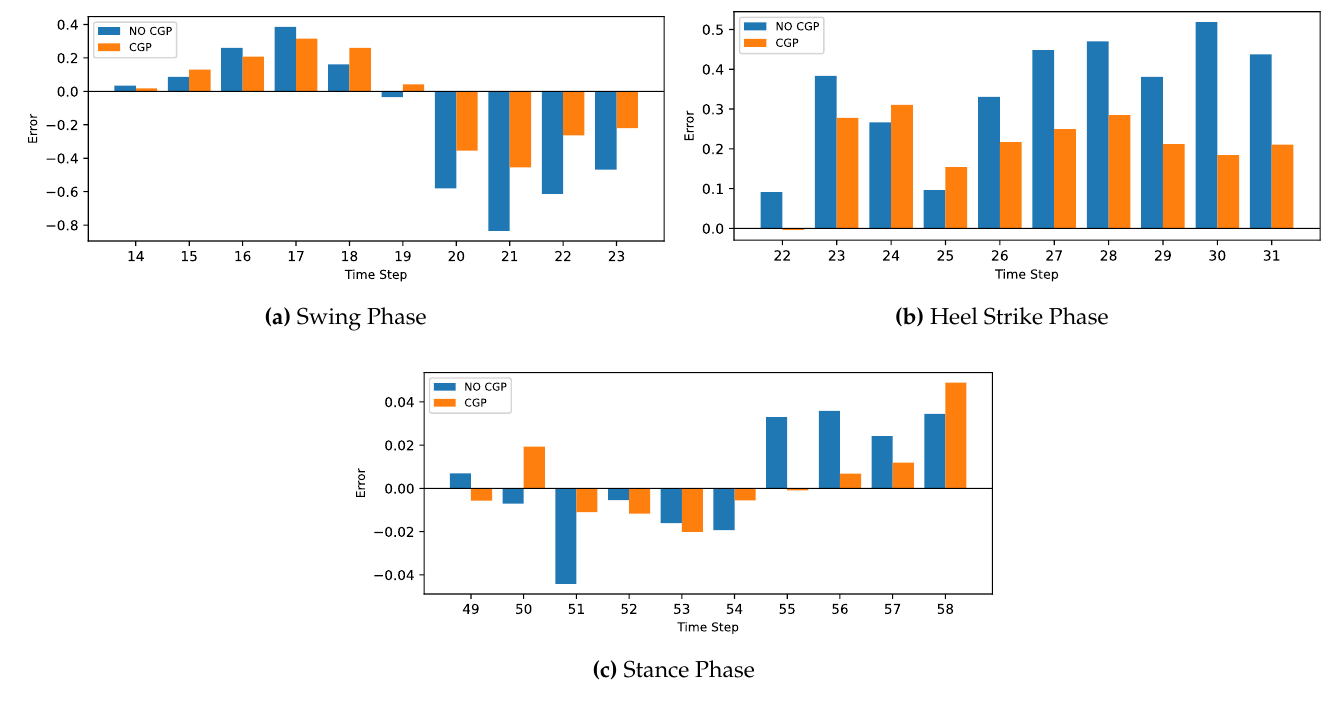
Figure 11. Comparison between two cases, with and without CGP for MLP model. Figure 12. Comparison between two cases, with and without CGP for the MLP